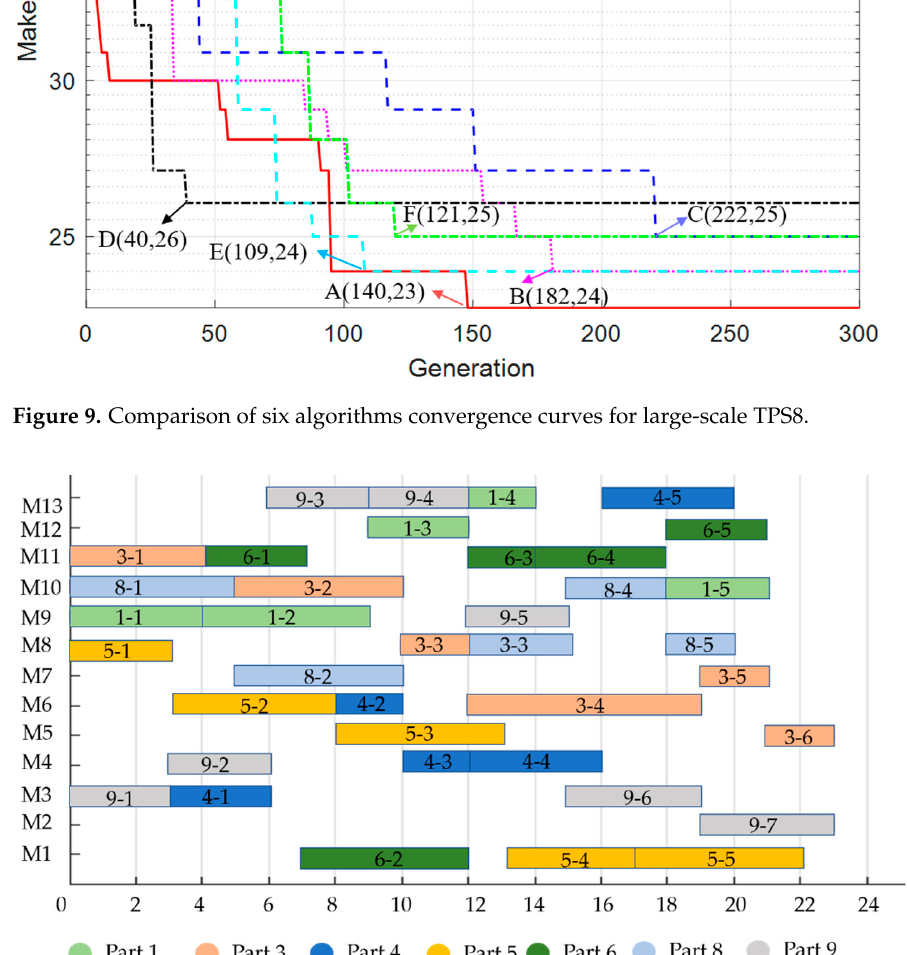
Figure 10. Resource Configuration Gantt charts obtained by IICA-NS algorithms.